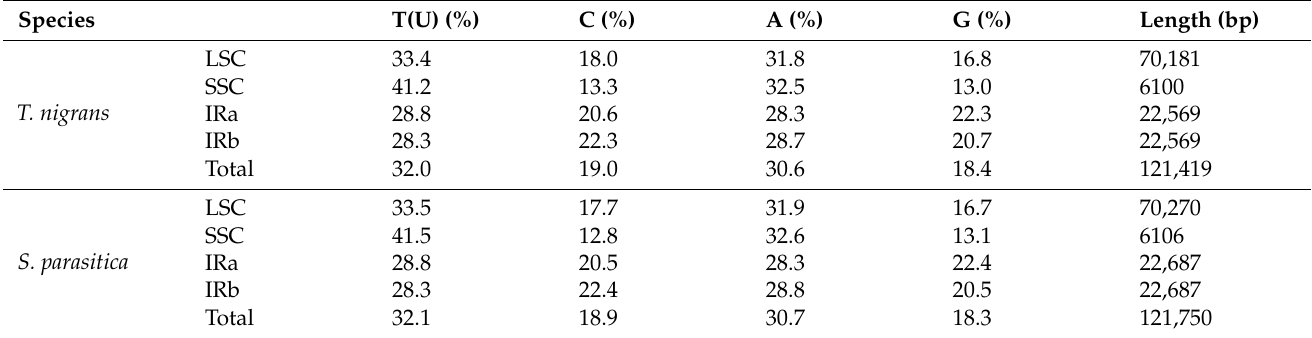
Table 1. Elemental composition in the T. nigrans and S . parasitica chloroplast genomes.